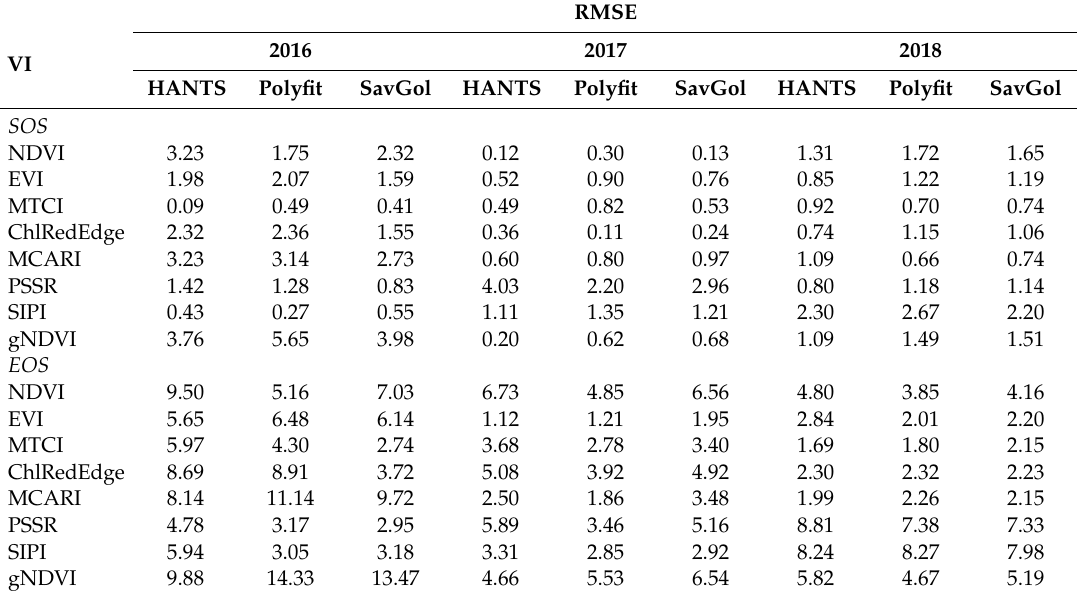
Table 3. Performance of each vegetation index (VI) and filtering methods (HANTS—Harmonic Analysis of Time Series; Polyfit—polynomial; SavGol—Savitzky–Golay) in simulating GPP time-series for each year and season (SOS—start of season; EOS—end of season), separately (see VI definitions in Table 1).